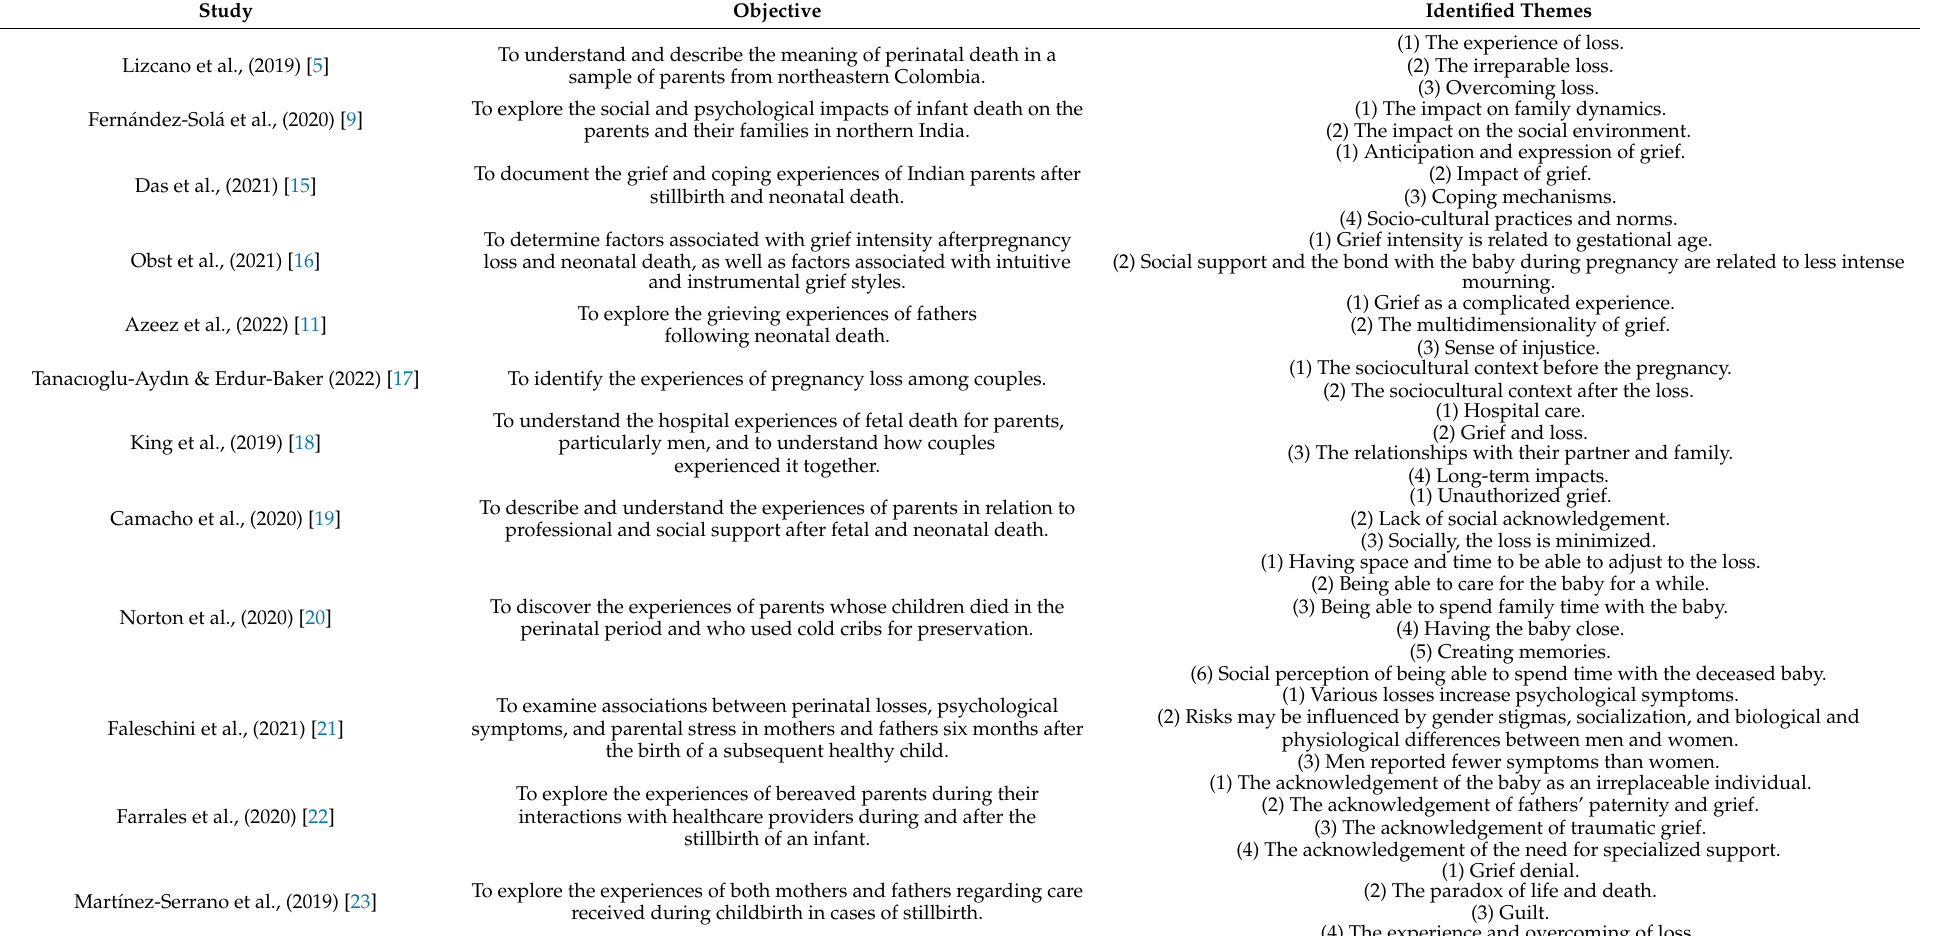
Table 2. Main findings of the